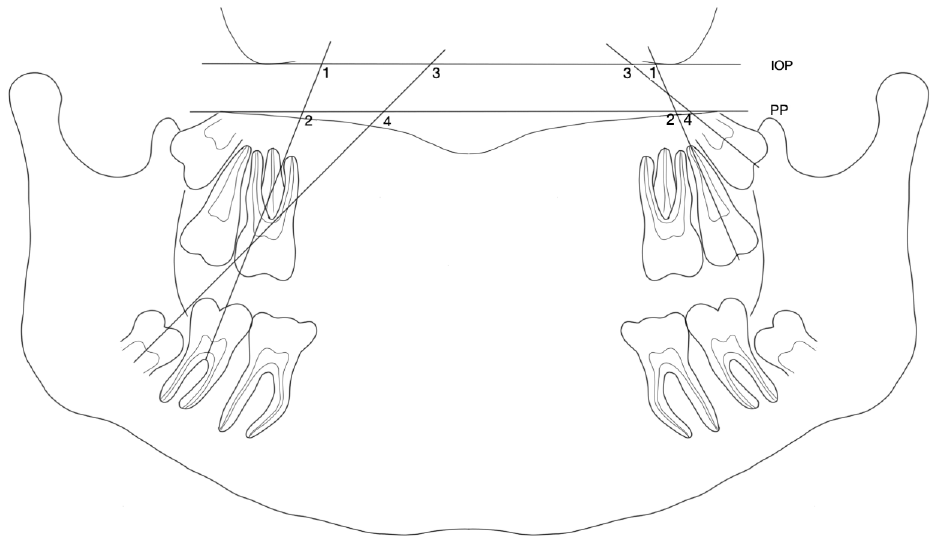
Figure 1. Diagram of angulation measurements. 1 mandibular/maxillary (Mb/Mx) second molar (M2) angulation to the infraorbital plane (IOP): M2/IOP ; 2 Mb/Mx M2 angulation to the palatal plane (PP): M2/PP ; 3 Mb/Mx third molar (M3) angulation to IOP: M3/IOP ; 4 Mb/Mx M3 angulation to PP: M3/PP .